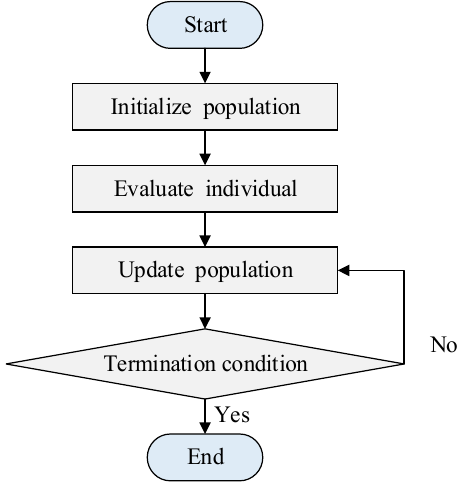
Figure 1. Evolutionary algorithm flow chart.